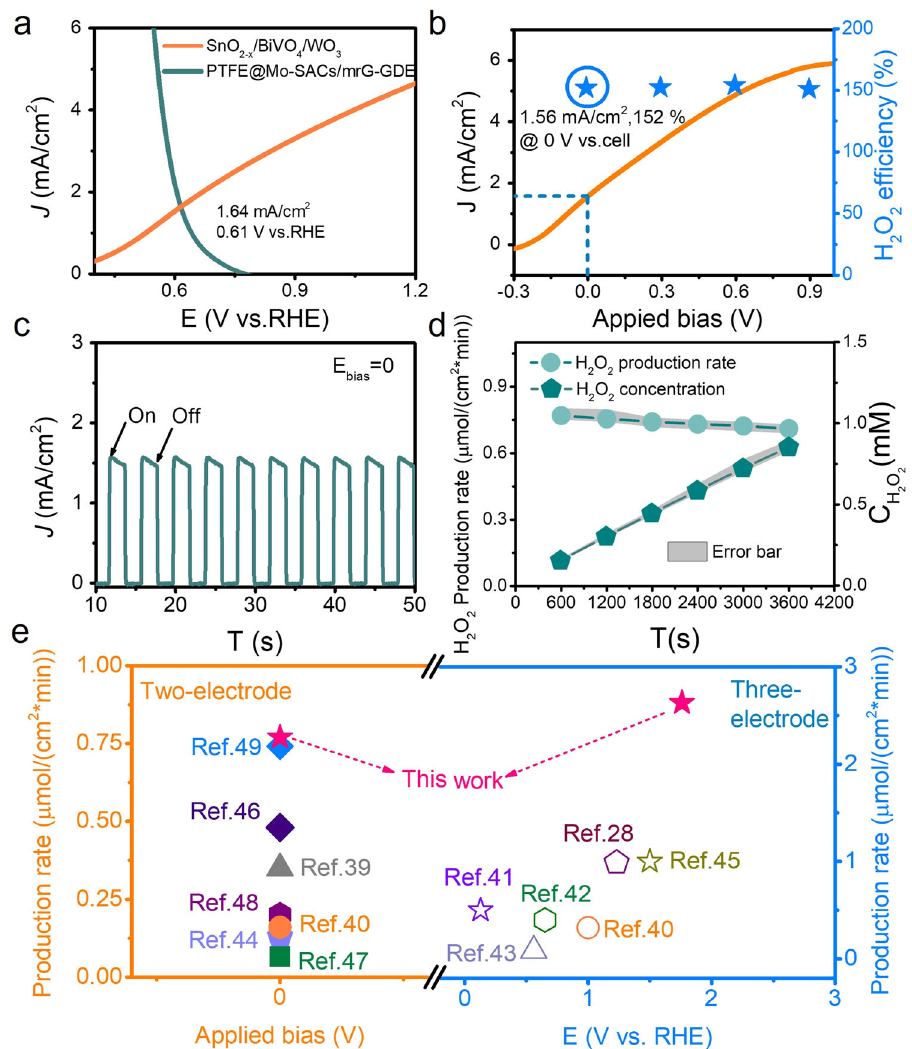
Fig. 5 | Coupling photoanode and cathode for solar-driven H 2 O 2 production and summary. a Coupled LSV scan of the SnO 2-x /BiVO 4 /WO 3 photoanode and PTFE@Mo-SACs/mrG-GDE cathode. b LSV scan of SnO 2-x /BiVO 4 /WO 3 ||PTFE@Mo- SACs/mrG-GDEunderatwo-electrodesystemandtheirH 2 O 2 FEatdifferentapplied voltages. c Photocurrent – time pro fi les under bias-free conditions. d H 2 O 2